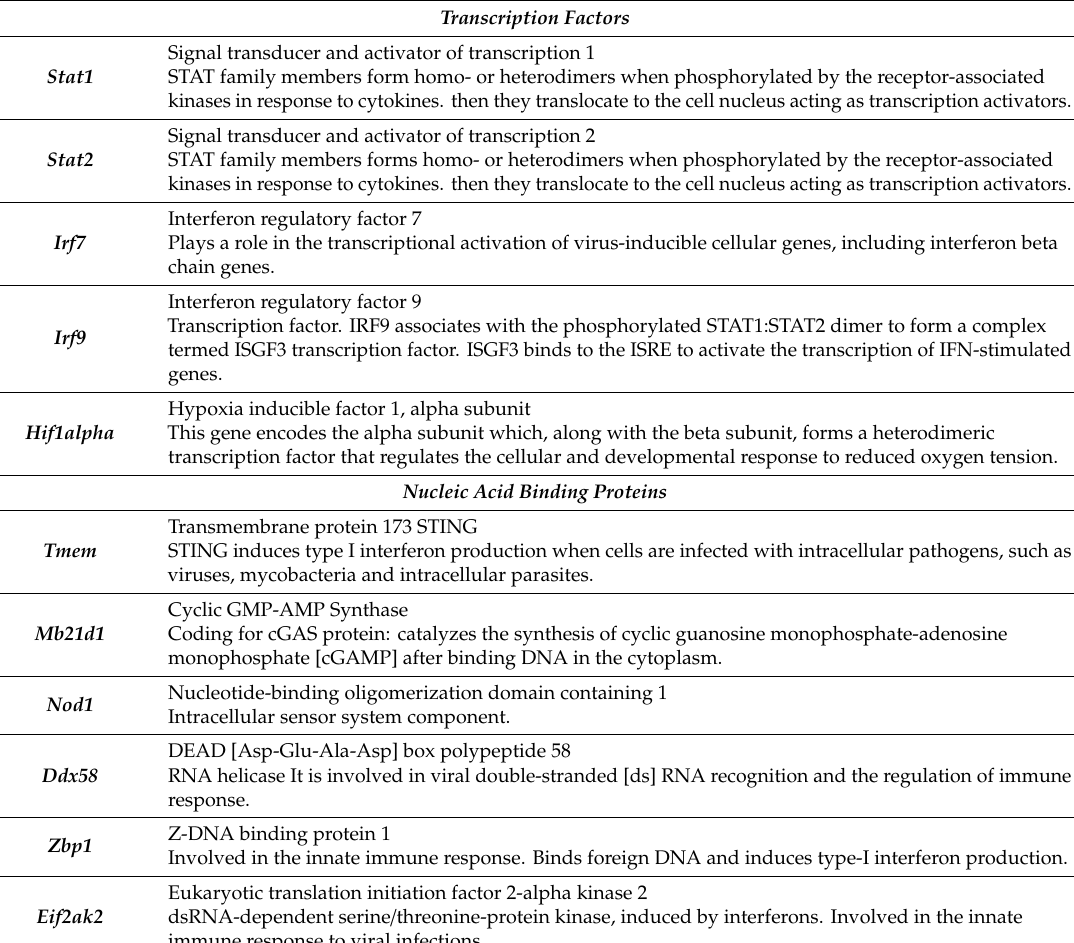
Table 2. Genes 1 overexpressed in dendritic cells (DC) treated with DEC205 targeted fd bacteriophage in comparison to untargeted